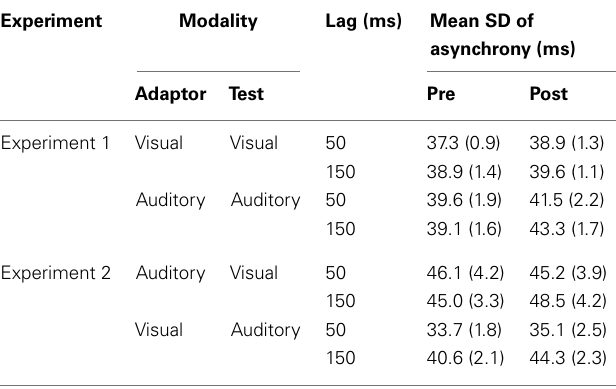
Table 2 | Mean standard deviation of tap-stimulus